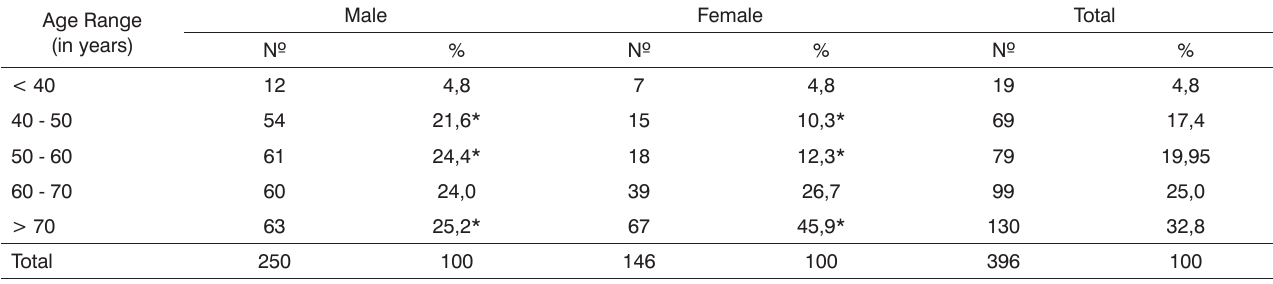
Table 1. Distribution of mouth squamous cell carcinoma patients according to sex and age Maceio-AL, 2000-2006. Age Range (in years)